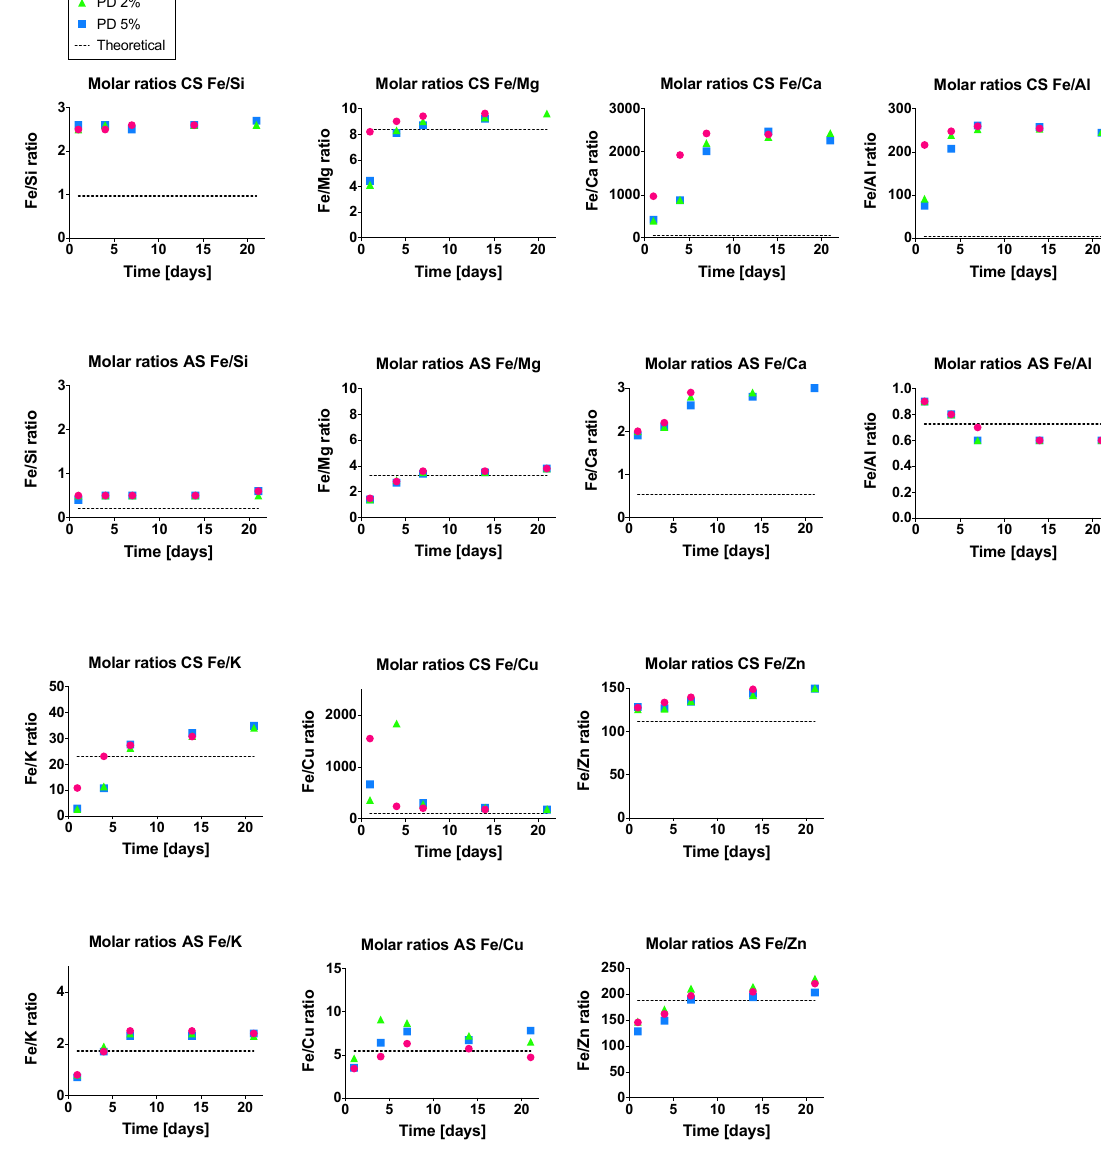
Figure 9. Molar ratios of metal versus Fe in biotic system with slags at various pulp densities.